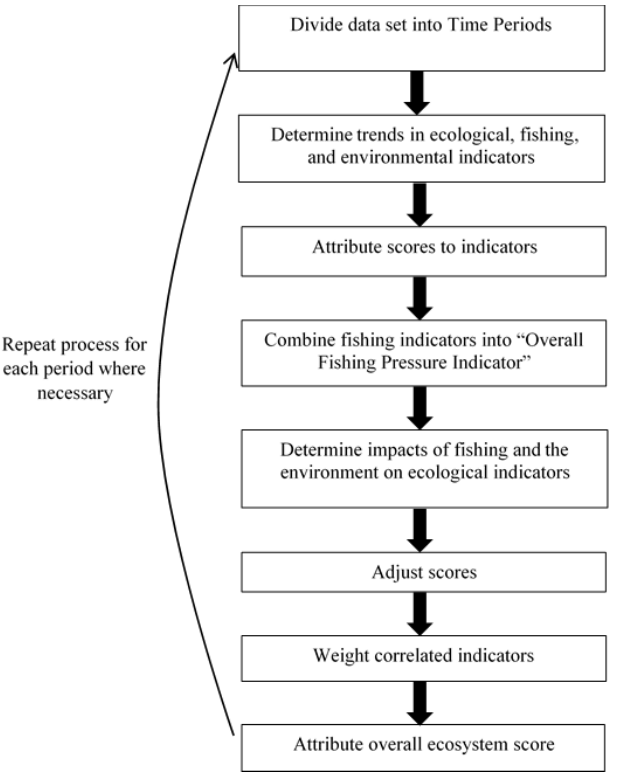
Fig. 1 . The step-by-step process of applying the developed framework to a marine ecosystem. First, it must be determined whether the data series must be divided into distinct periods based on known shifts in drivers. Trends in ecological, fishing, and environmental indicators are then determined using linear regressions, and scores are attributed to indicators based on the direction and significance of observed trends. Fishing indicators are combined into one indicator of overall fishing pressure to simplify the decision tree framework. The impacts of fishing pressure and environmental variability are determined, and scores are adjusted to account for these impacts. A reduced weighting is applied to correlated indicators to account for potential redundancies. Then finally the ecosystem is attributed an “overall ecosystem score.”